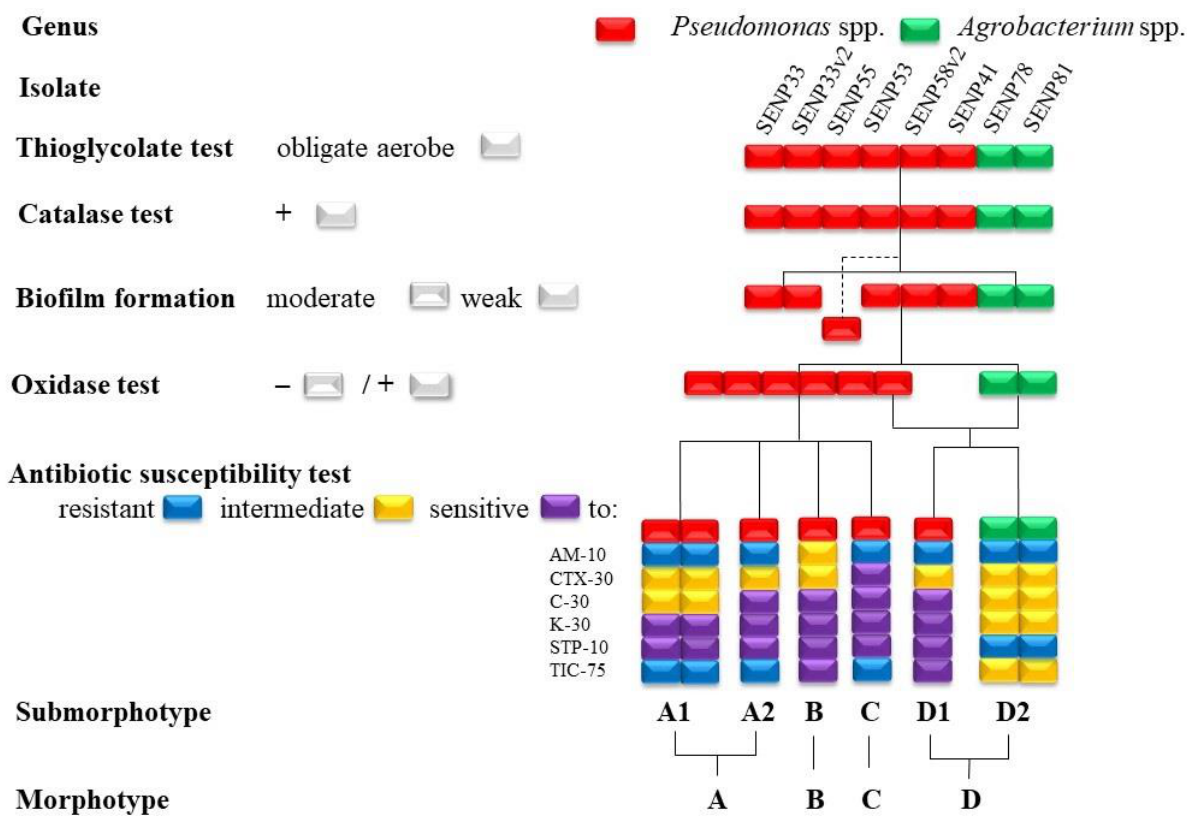
Figure 3. Physiological test results of oxygen requirements (thioglycollate test), biofilm formation, catalase and oxidase production, and antibiotic susceptibility against ampicillin (AM), cefotaxime (CTX), chloramphenicol (C), kanamycin (K), streptomycin (STP), and ticarcillin (TIC), where the numbers beside the letters indicate the concentrations of antibiotics in micrograms. The dotted line by the biofilm formation test indicates the separation of only one isolate (SENP55) with moderate biofilm formation. The red and green rectangles in the diagram indicate the genus of the isolates. The separation into sub-morphotypes was caused by variations in the results of antibiotic susceptibility testing.